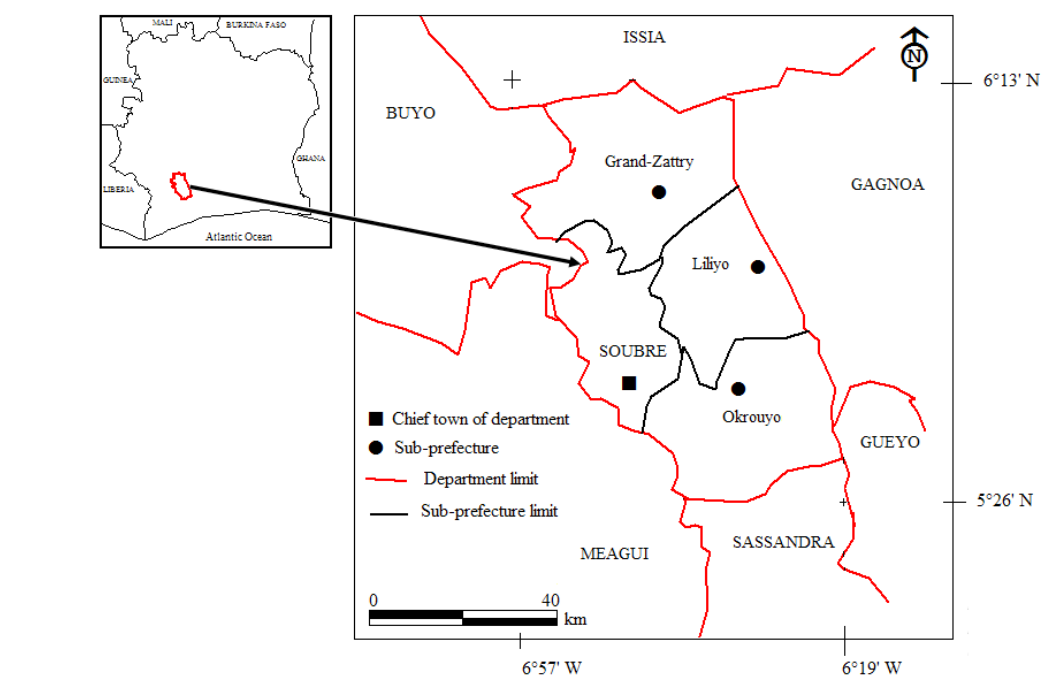
Figure 1. Map localisation of the study area